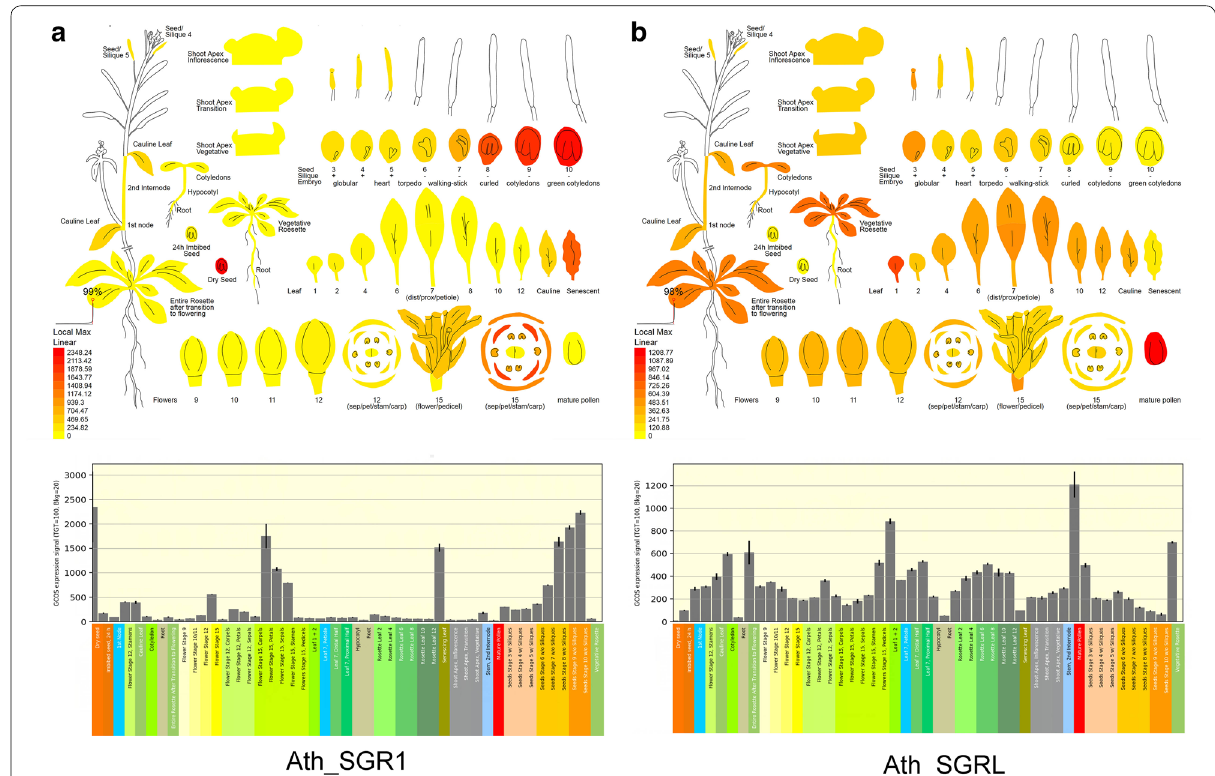
Fig. 3 The spatiotemporal expression patterns of SGR1 and SGRL in Arabidopsis . a The expression levels of SGR1 in Arabidopsis in various tissues and at various development stages. b The expression levels of SGRL in Arabidopsis in various tissues and at various development